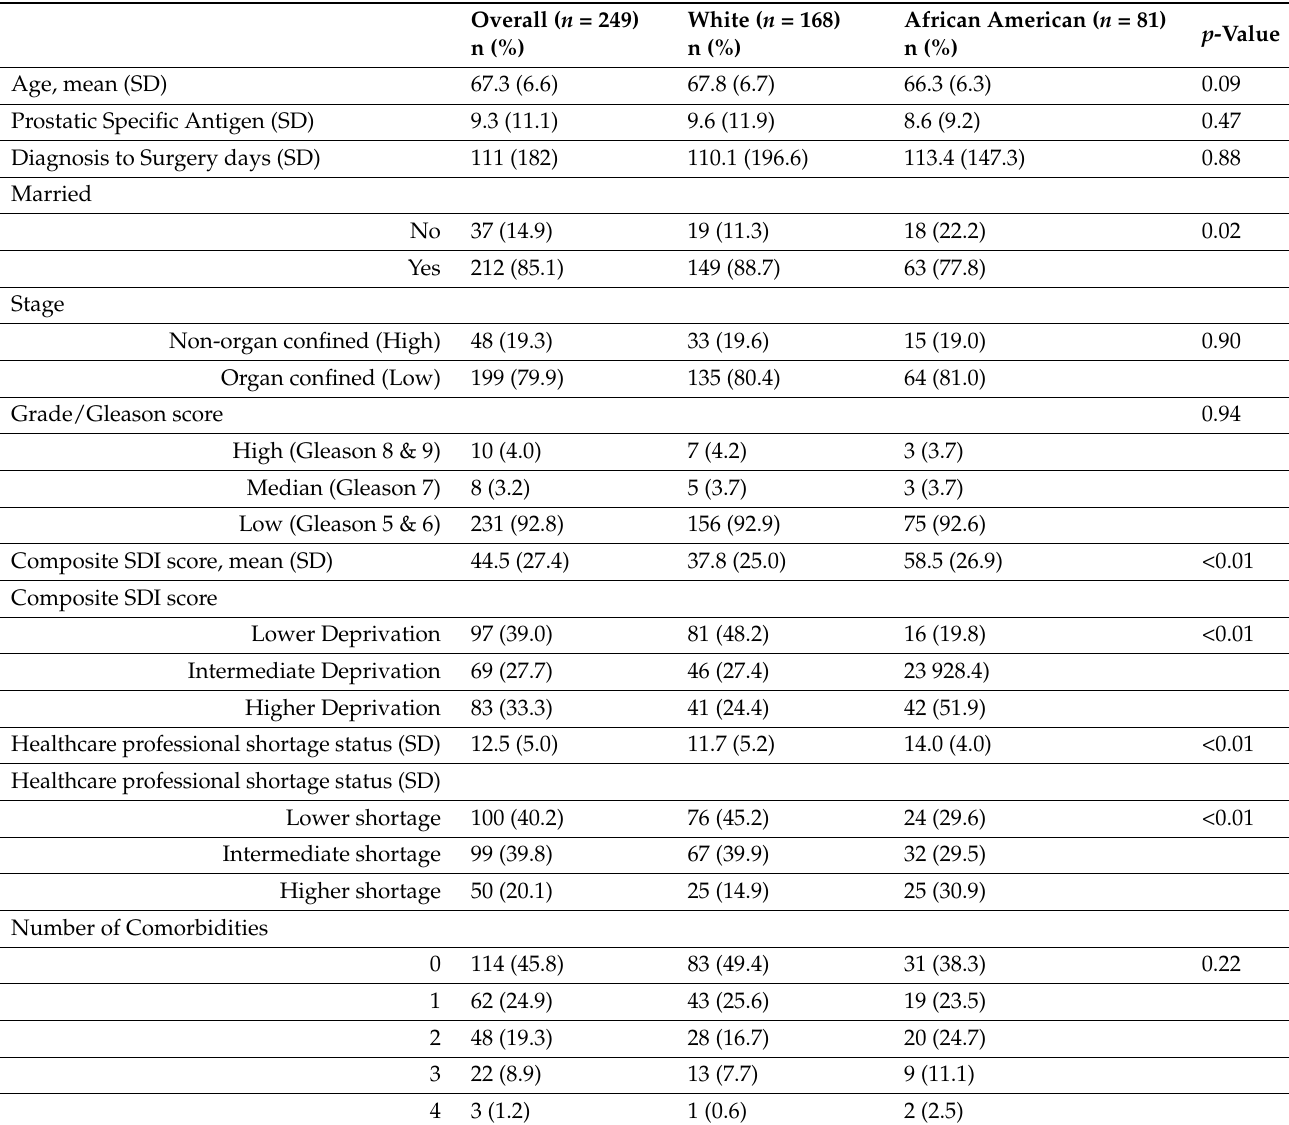
Table 1. Sociodemographic and clinical characteristics ( n =